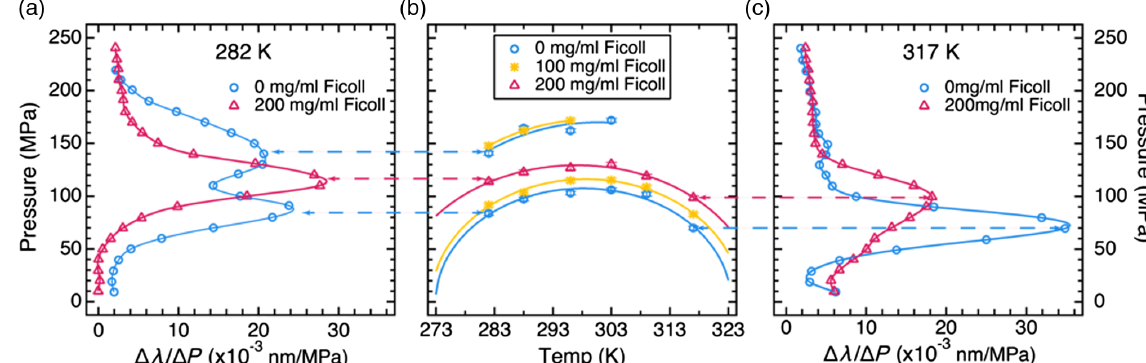
FIG. 3. Experimental T - P - ϕ phase diagram of PGK (full data in Ref. [10]). (a) The derivative of the mean tryptophan fluorescence wavelength vs the pressure of PGK at 282 K calculated from fluorescence spectra. Two of six Ficoll 70 concentrations are shown. The markers show the data points, and the solid line shows a cubic spline interpolation. The blue curve ( 0 mg = ml Ficoll 70) has two peaks as the pressure increases, signifying two transitions; the magenta curve ( 200 mg = ml Ficoll 70) has only one peak point, signifying only one transition when pressure is applied. The dashed lines point from transition midpoints to the corresponding point in the phase diagram. (b) P - T phase diagrams at several ϕ obtained by fitting the fluorescence data to obtain the inflection points of λ = ∂ P ). Three of six Ficoll 70 concentrations are shown. Circles represent midpoint pressures measured at 282, 288, 296, derivative ∂ λ m 303, 309, and 317 K in absence of Ficoll 70 ( 0 mg = ml), asterisks represent transitions for the middle Ficoll 70 concentration ( 100 mg = ml), and triangles represent transitions for the highest Ficoll 70 concentration ( 200 mg = ml). At high T , or upon increasing the Ficoll 70 concentration, the second (higher P ) transition disappears, mapping out a critical point that moves to a lower T Ficoll 70 concentration. Solid elliptical curves going through the circles are fits to Eq. (4) representing the Δ G ¼ 0 curves. (c) Equivalent data as in (a) at 317 K. Note that the second (higher P ) transition is never present at high T